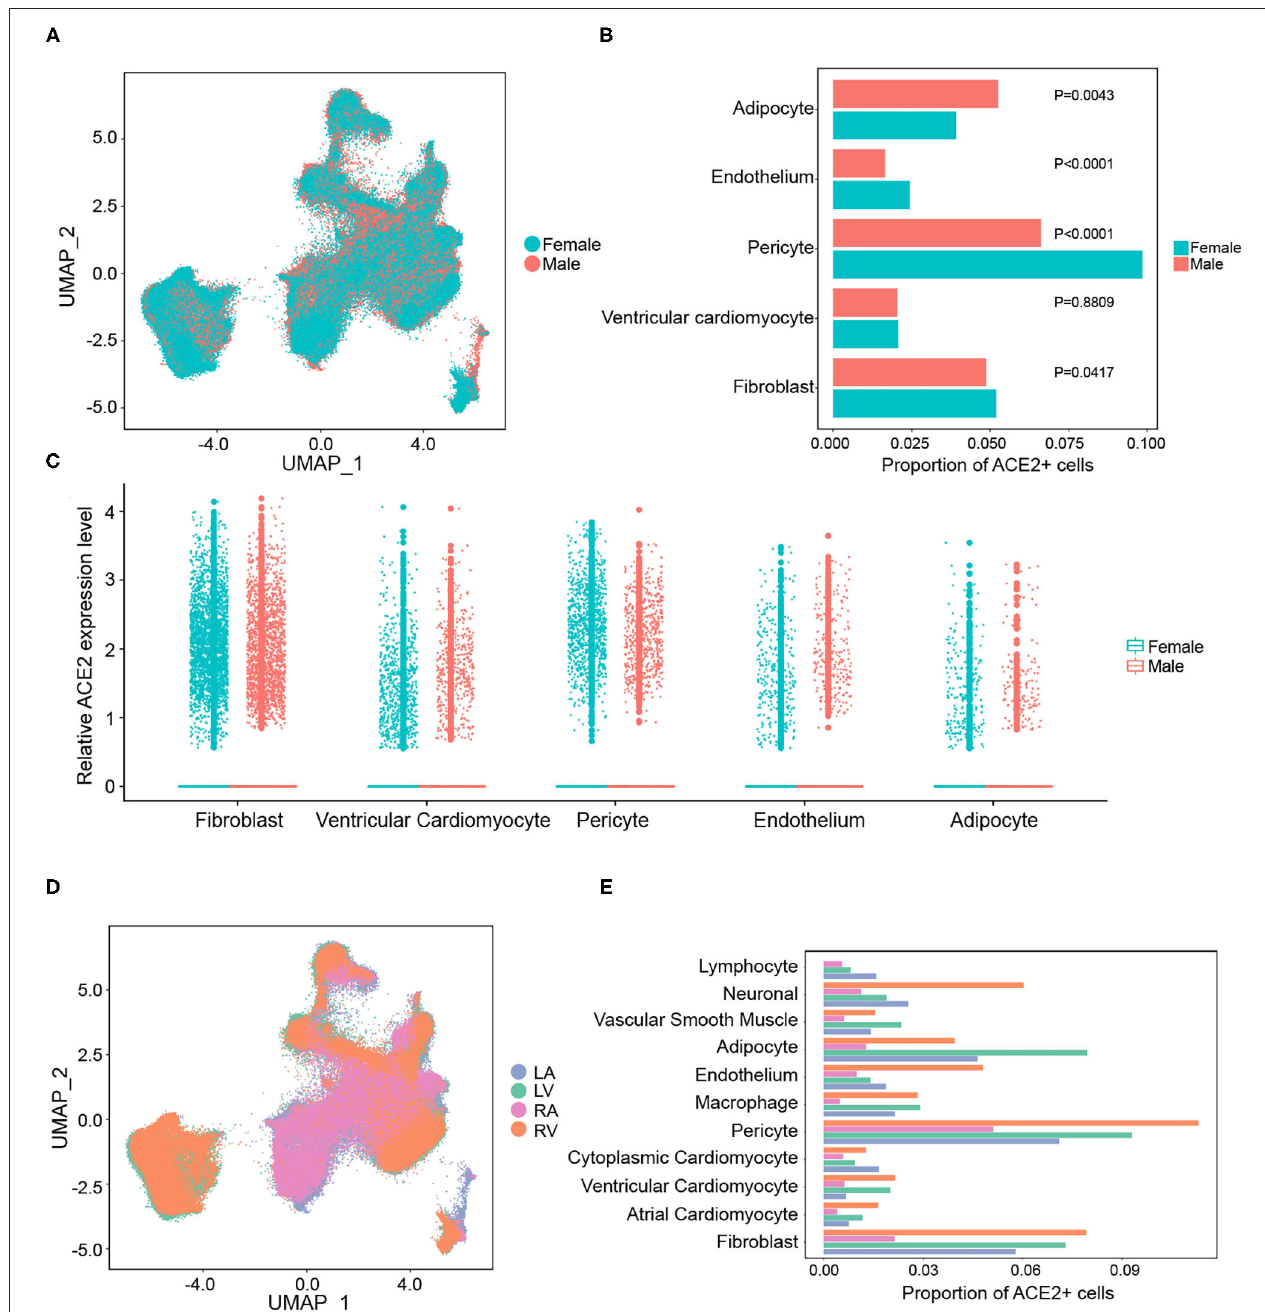
FIGURE 2 | Gender and regional differences in the expression of ACE2 in the human heart. (A) The overall distribution of cardiac cells between sexes. (B) The gender-differentiated effect on the percentage of ACE2-positive cells in main cell clusters. (C) The expression levels of ACE2 between sexes in different cell types. (D) The distributions of gene expression in cells from different chambers of the heart. (E) The proportion of ACE2-positive cells in each cell cluster from different cardiac